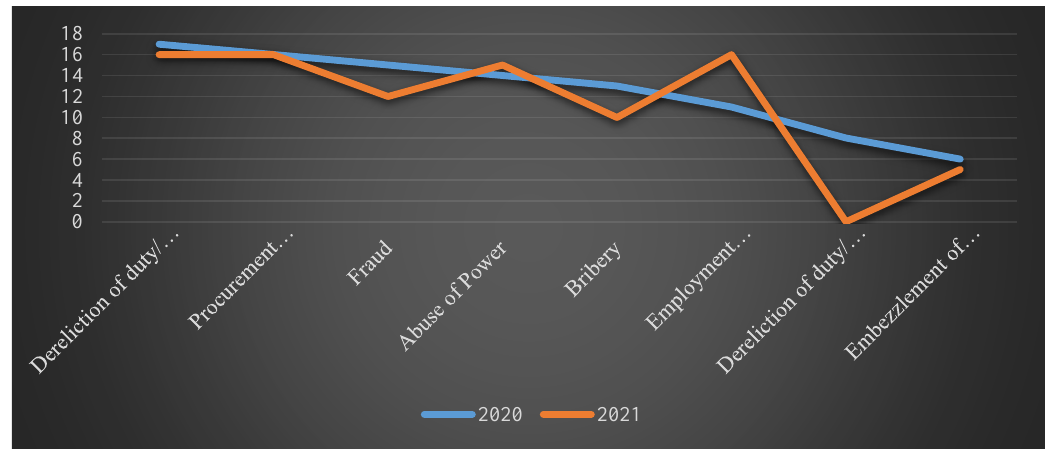
Graph 1. Trend of Corruption Pattern Recorded During 2020 and